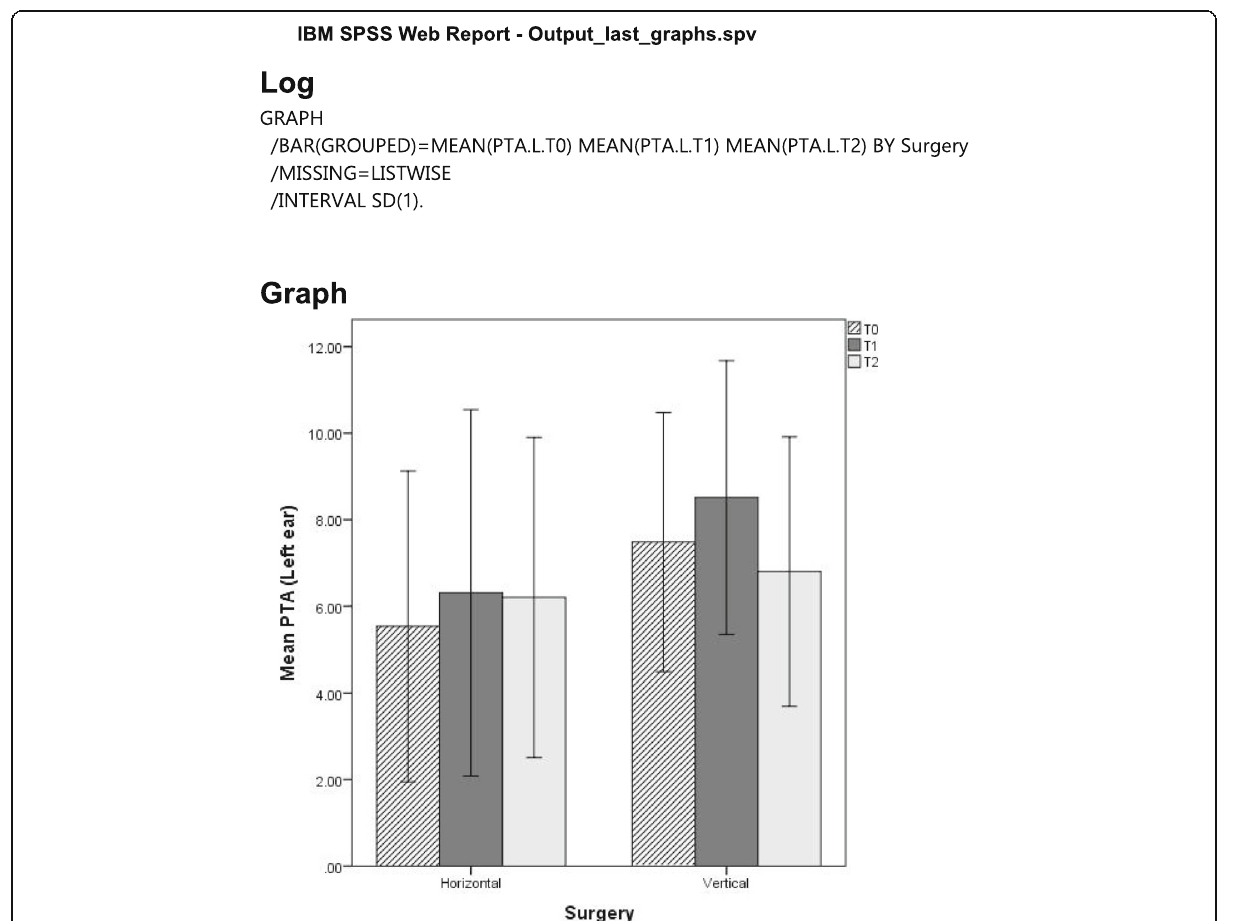
Fig. 2 Mean PTA over time according to the type of movements (horizontal or vertical) in the left